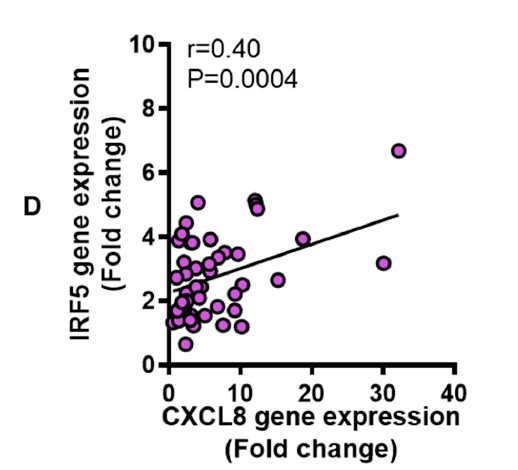
Figure 5. Upregulated adipose tissue chemokine CXC motif ligand-8 (CXCL8) expression in obesity. Adipose CXCL8 gene expression was determined in five lean, 18 overweight, and 27 obese non-diabetic individuals using real-time RT-PCR, while CXCL8 protein expression was determined in six lean, 14 overweight, and 10 obese non-diabetic individuals using immunohistochemistry (IHC) as described in Materials and Methods. The data (mean ± SEM) show that ( A ) adipose CXCL8 gene expression was upregulated in obese (P = 0.05) compared with lean individuals. ( B ) CXCL8 protein expression (IHC intensity in arbitrary units) was also higher in obese (P = 0.0001) compared with lean individuals. ( C ) The representative IHC images obtained from three independent determinations with similar results show upregulated adipose CXCL8 expression (purple arrows, 100 × magnification) in overweight and obese as compared with lean individuals. Scale bar = 50 µ M. ( D ) IRF5 and CXCL8 gene expression was associated with each other in the adipose tissue (r = 0.40, P = 0.0004). The asterisks * and *** represent significance levels of P ≤ 0.05 and P < 0.001,